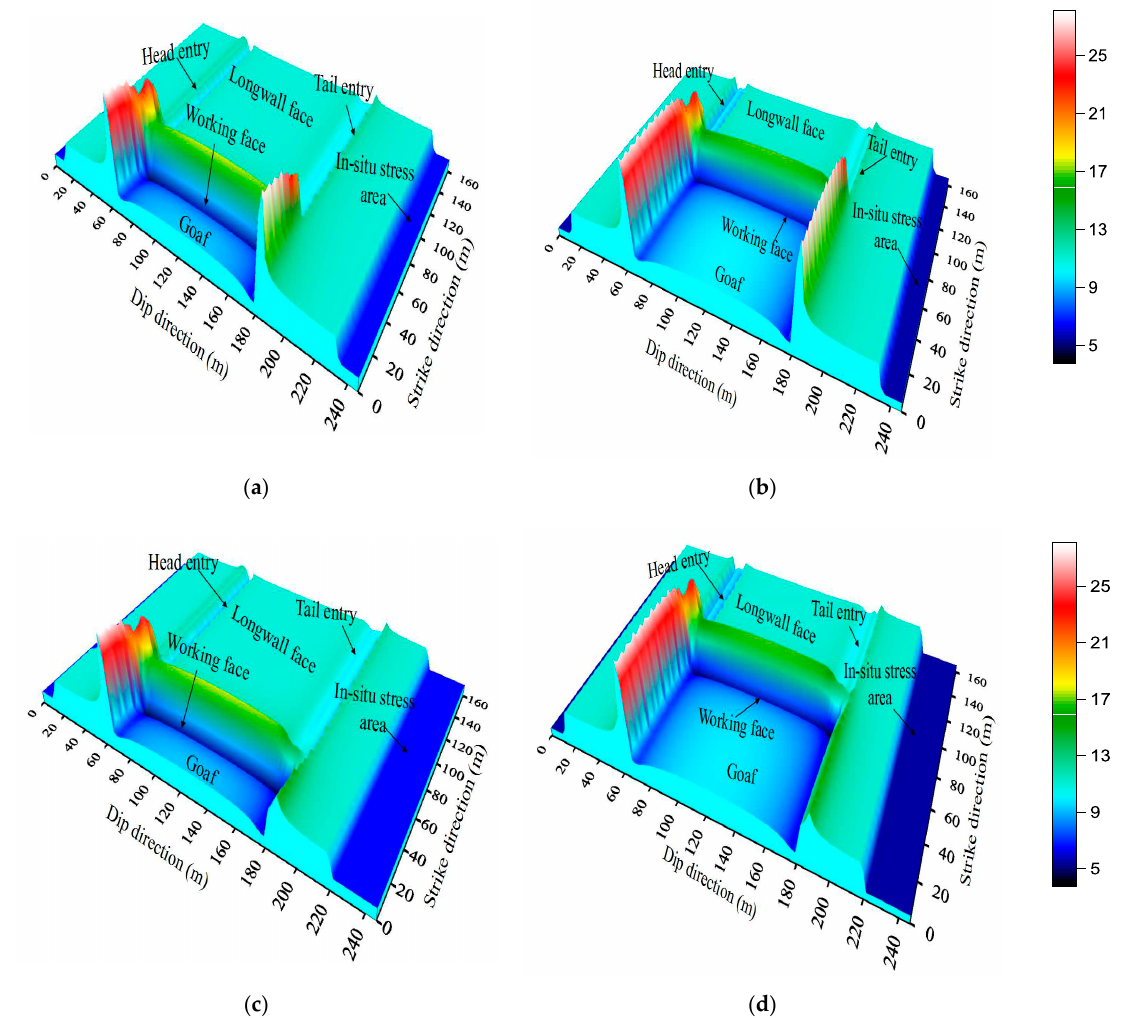
Figure 15. The three-dimensional cloud maps of the abutment stress distribution: ( a ) The stress distribution of 40m exploitation without roof cutting. ( b ) The stress distribution of 80m exploitation without roof cutting. ( c ) The stress distribution of 40m exploitation with roof cutting. ( d ) The stress distribution of 80m exploitation with roof cutting. From the three-dimensional cloud maps, we can deem that the overall stress will change after the panel is mined. When the roof of mined out area has not completely